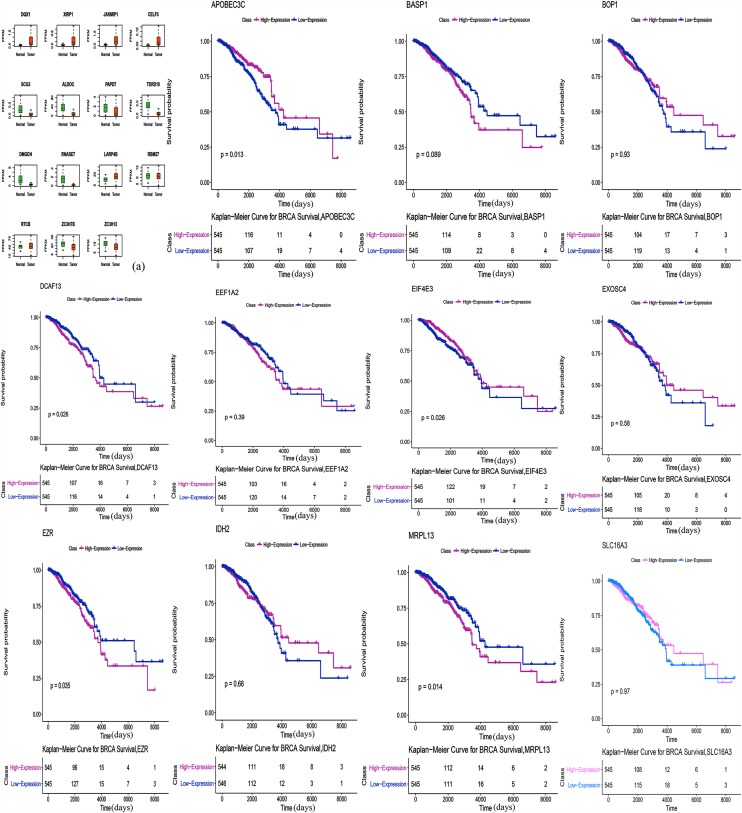
Survival Kaplan-Meier Estimate (EZR p = 0.035, DCAF13 p = 0.026, MRPL13 p = 0.014, APOBEC3C p = 0.013, and EIF4E3 p = 0.026). Expression of selected target genes in tumor and normal tissues was significantly different.